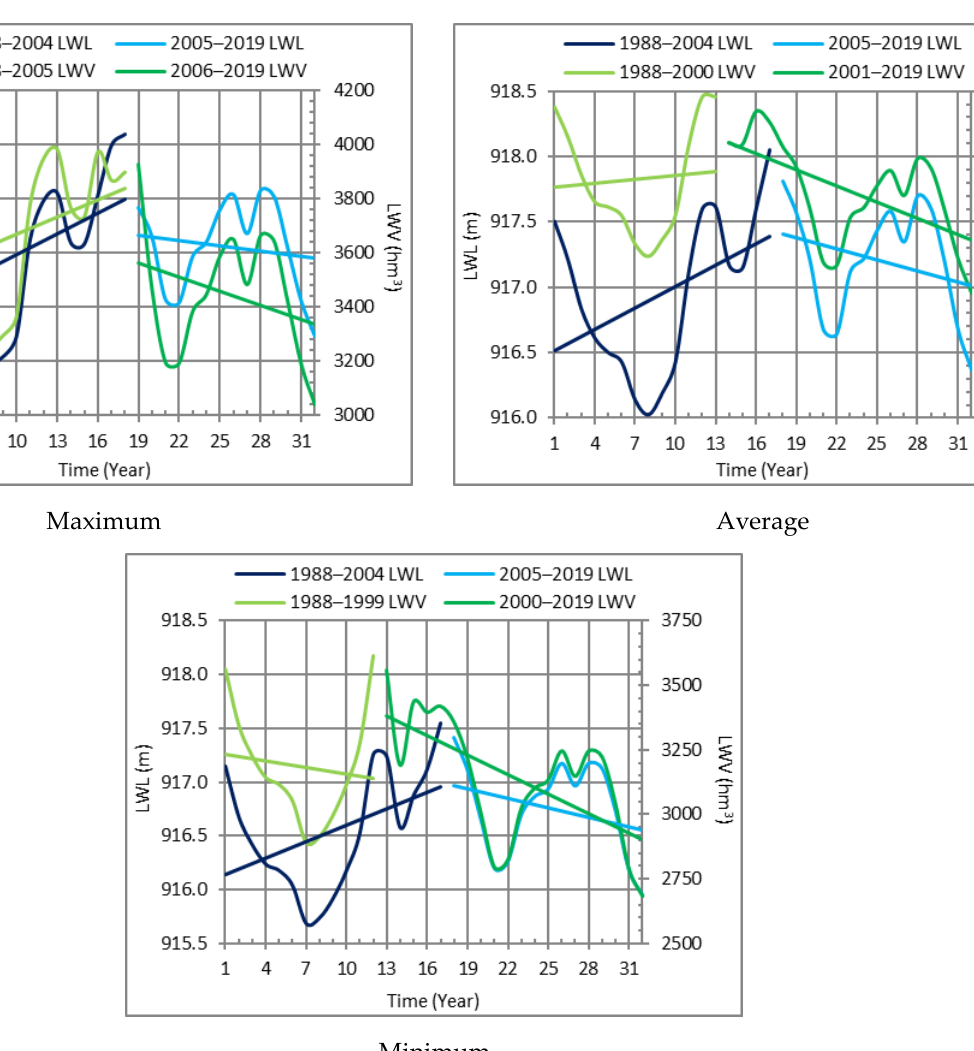
Figure 4. Linear regression analysis for different periods of Lake Eğirdir annual LWL and LWV series.